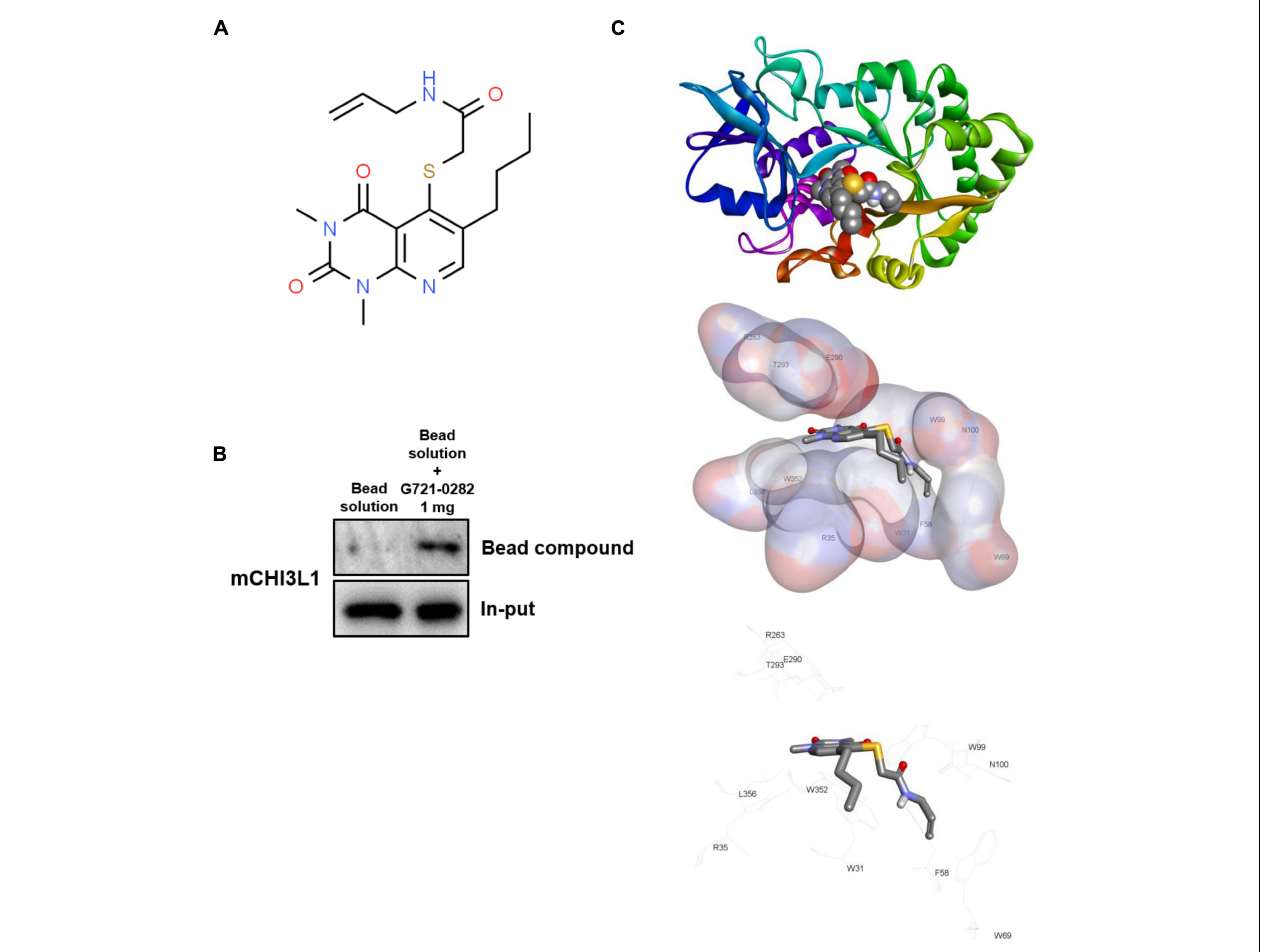
FIGURE 1 | G721-0282 directly binds to CHI3L1. Chemical structure of G721-0282 (A) . Whole cell lysate of BV-2 cells were incubated with G721-0282-conjugated Sepharose 6B. After precipitation, the levels of bound CHI3L1 were monitored by Western blot analysis (B) . Docking model of G721-0282 and CHI3L1 (C)